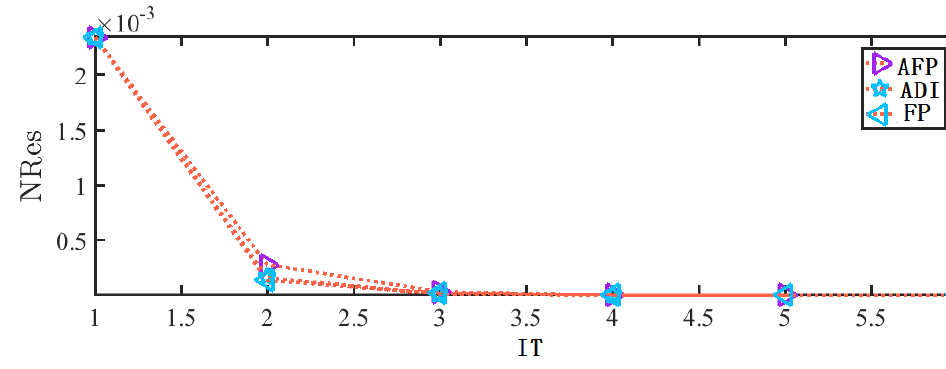
Figure 3. The relation of IT and NRes for the three algorithms P 0 = ˜ P 1